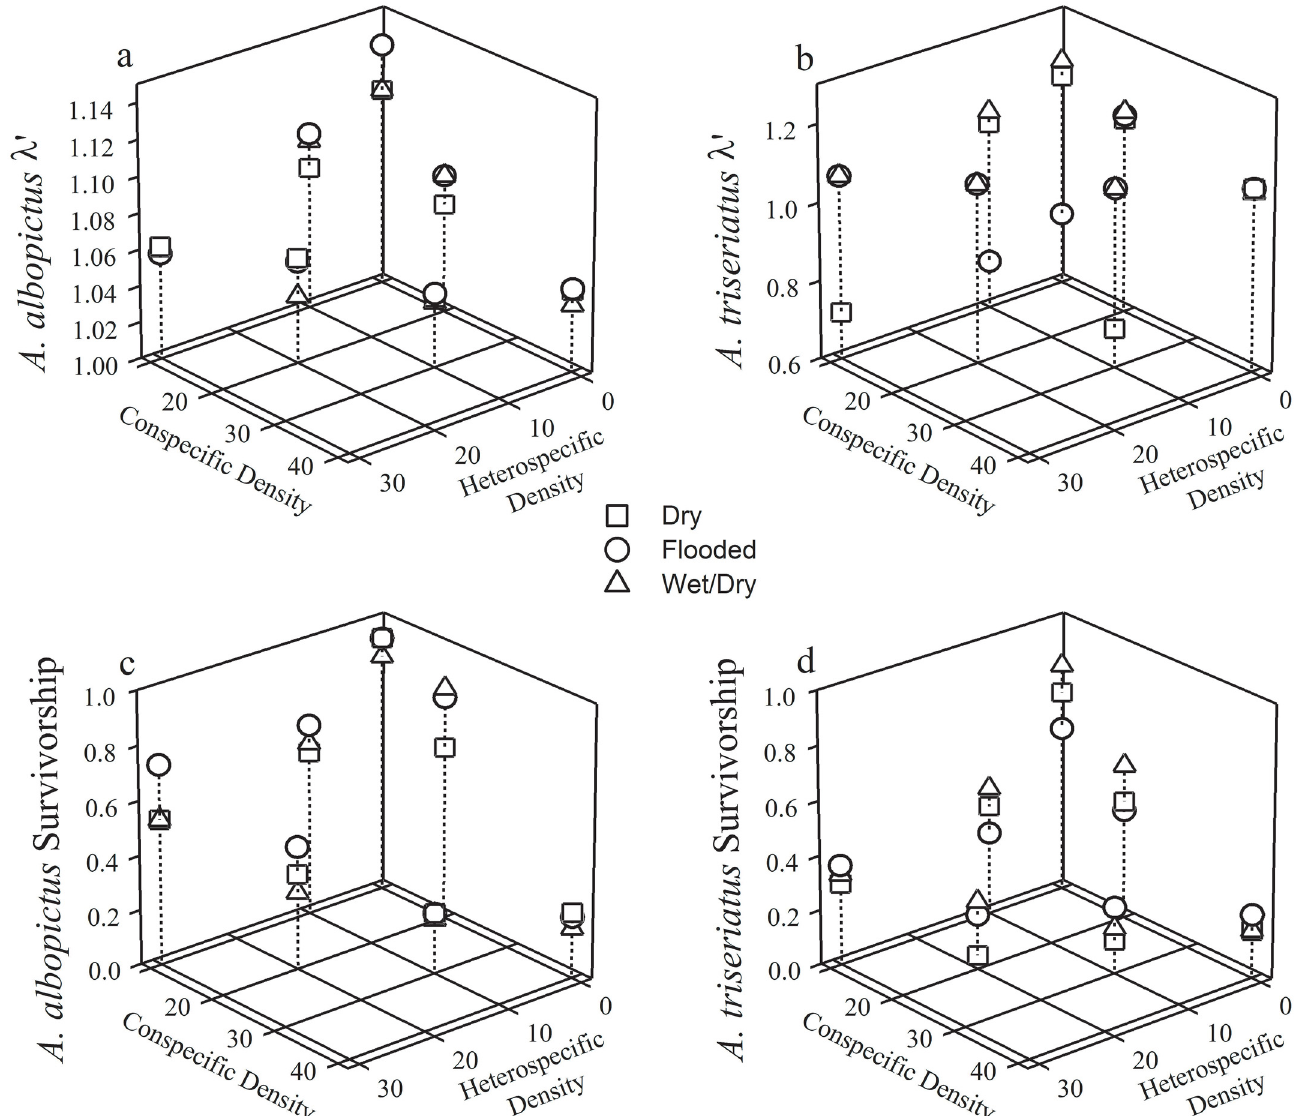
Fig 2. Mosquito Competition Results. Effects of competition densities and leaf litter on the finite rate of population increase λ ' (a, b) and survivorship (b, c) of Aedes albopictus and Aedes triseriatus